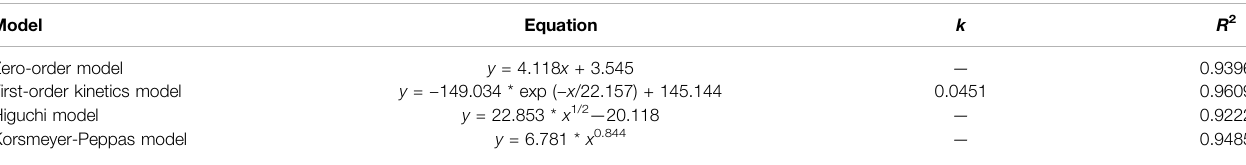
TABLE 6 | The kinetic models simulated for the release behavior of GLT-PM-MS. Model Equation k R 2 Zero-order model y (cid:2) 4.118 x +